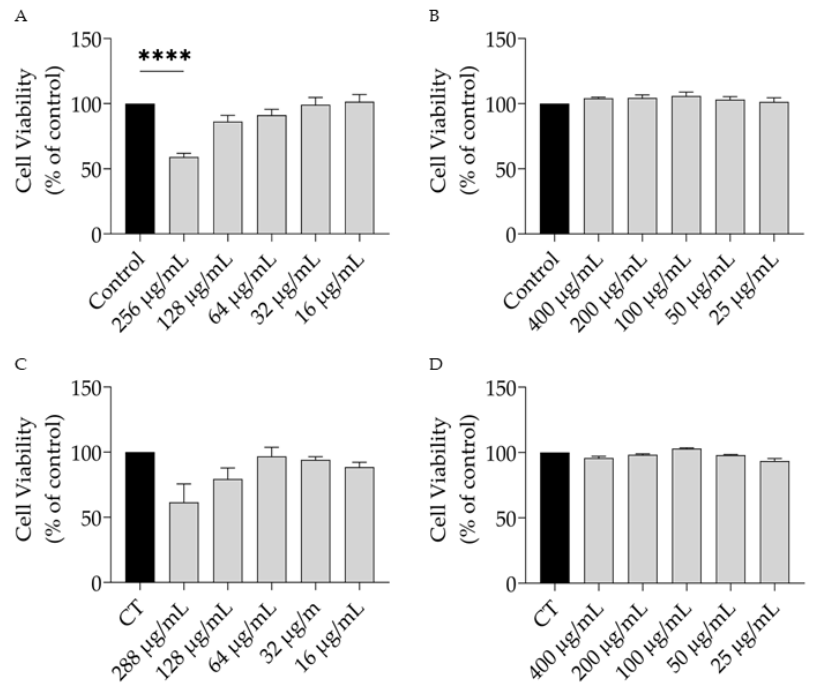
Figure 3. Safety profile of T. capitata essential oil (EO) and hydrodistillation residual water (HRW) towards macrophages ( A , B ) and fibroblasts ( C , D ). **** p < 0.0001 when compared to control after one-way ANOVA followed by Dunnet’s multiple comparison test.